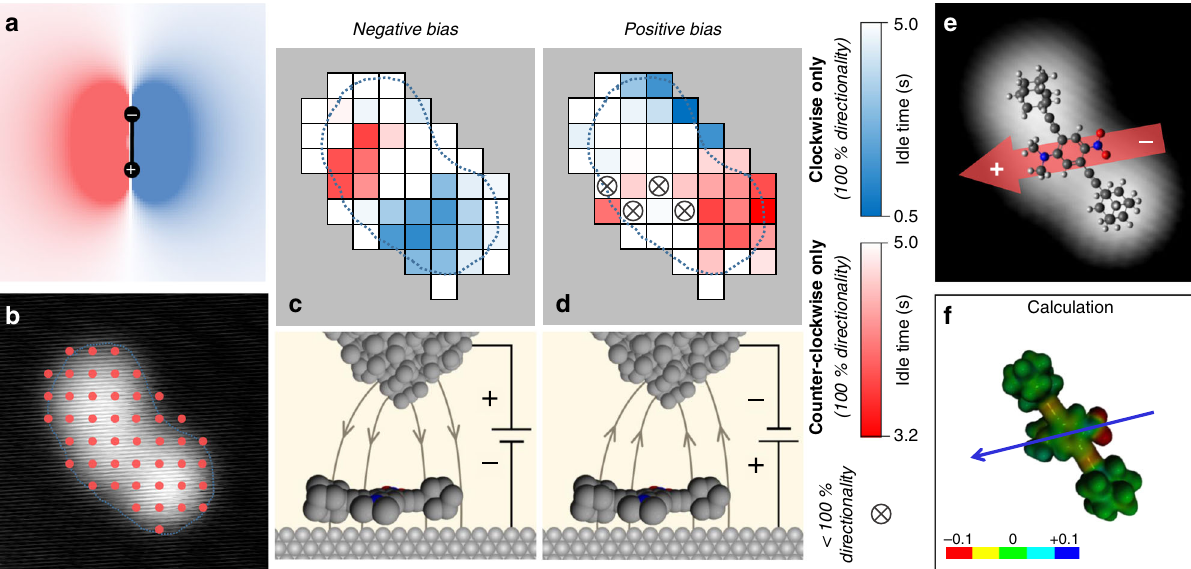
Fig. 3 Mapping the dipole moment in a single molecule. a Simulation of the torque acting on an electric dipole (shown in black) from a positive test charge placed at different locations (see Supplementary Fig. 6 for details). Blue (red) areas represent clockwise (counter-clockwise) rotation of the dipole, respectively and the contrast indicates the magnitude of torque. b Voltage pulses were applied in 46 positions (red dots) over a single molecule. If the resulting rotation is clockwise or counter-clockwise, the pixel is colored blue or red, respectively. c , d Rotational maps for negative and positive sample bias with legend to the right (crossed circles if both directions of rotation occurred) and schematic representations of the electric fi eld below. e Orientation of the internal dipole deduced from the maps in c , d , which is in agreement with the calculated charge distribution and dipole (blue arrow) of the adsorbed molecule ( f colors give different potentials in units of elementary charge e , see Supplementary Fig.